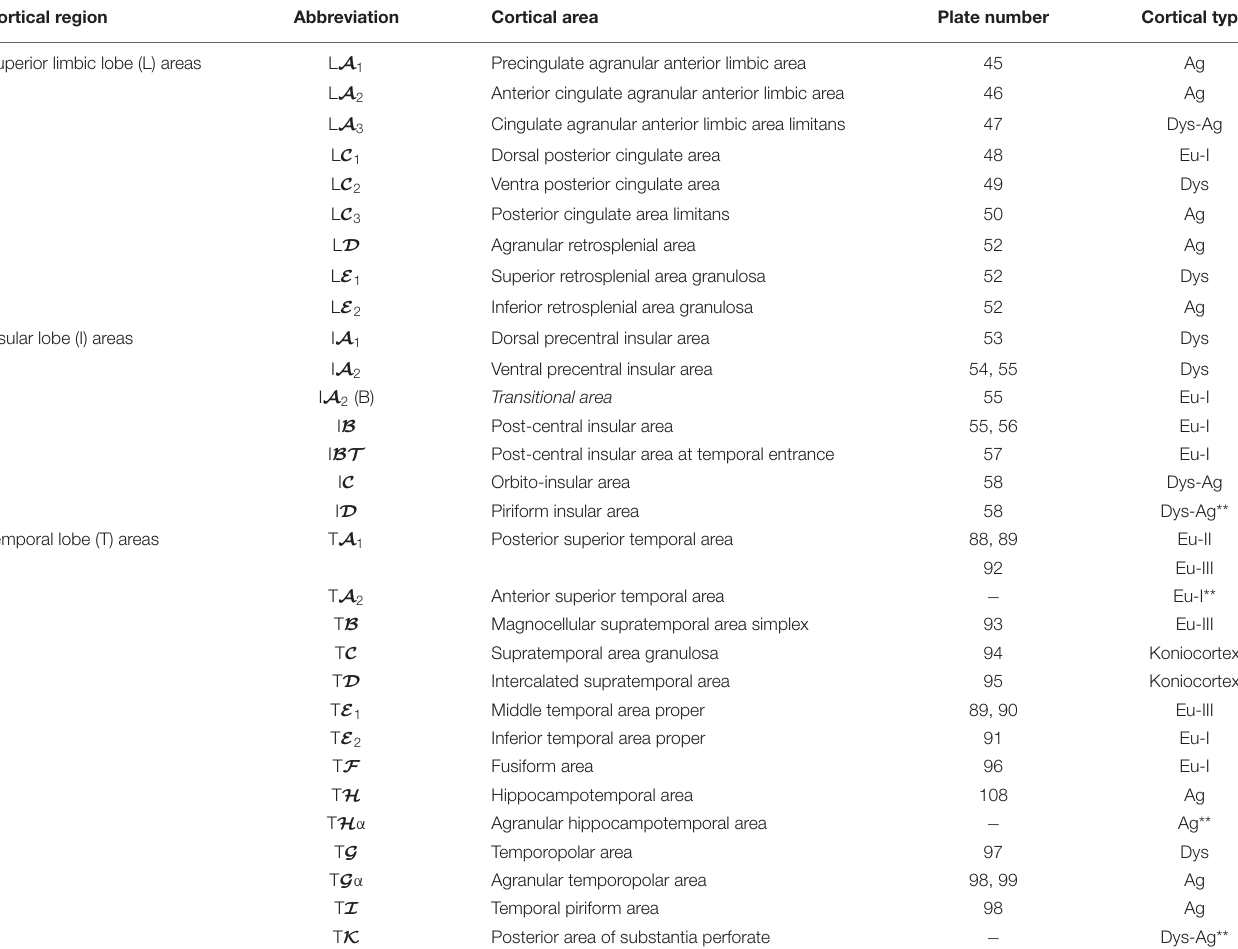
TABLE 6 | Areas in the human cerebral cortex according to von Economo and Koskinas (1925/2008) and their corresponding types: Limbic, insular, and temporal lobes. Cortical